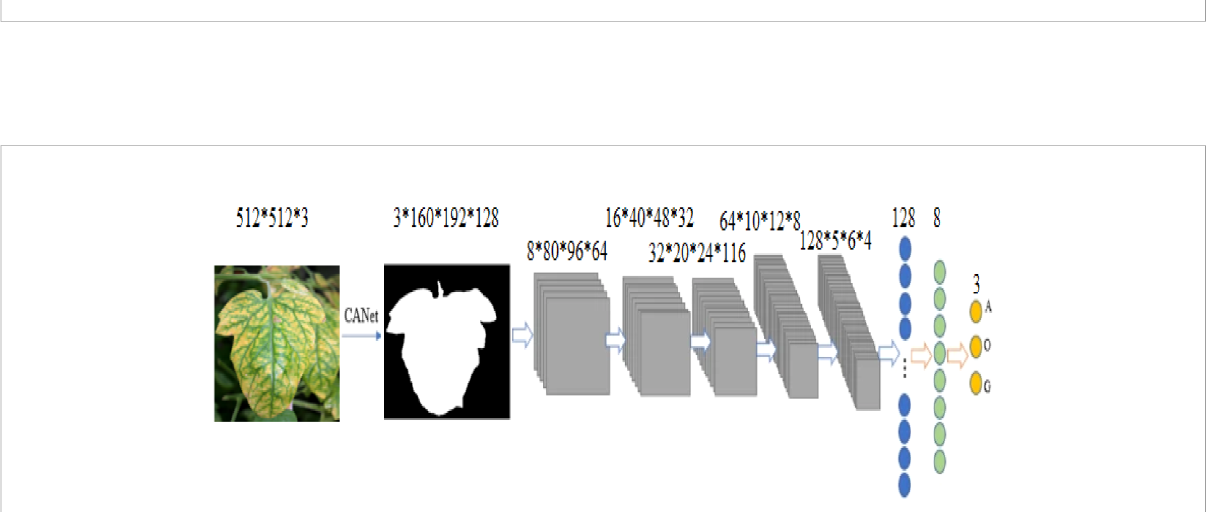
FIGURE 4 Overview of Semantic Segmentation for plant leaf lesion classi fi cation. In the fi rst phase, the images are segmented by the CANet model which are then fed into the CNN classi fi er for disease subtype classi fi cation.